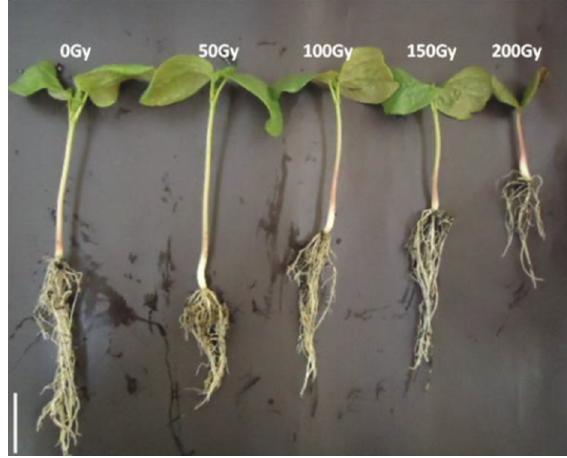
Figure 3 - Analysis of castor bean seedlings showing the total length of seedlings exposed to diff erent doses of Co 60 gamma radiation after 21